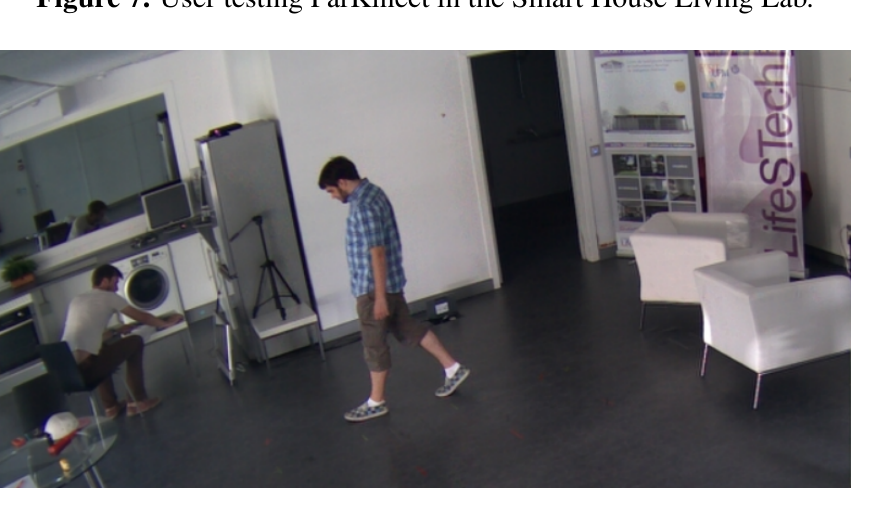
Figure 7. User testing ParKinect in the Smart House Living